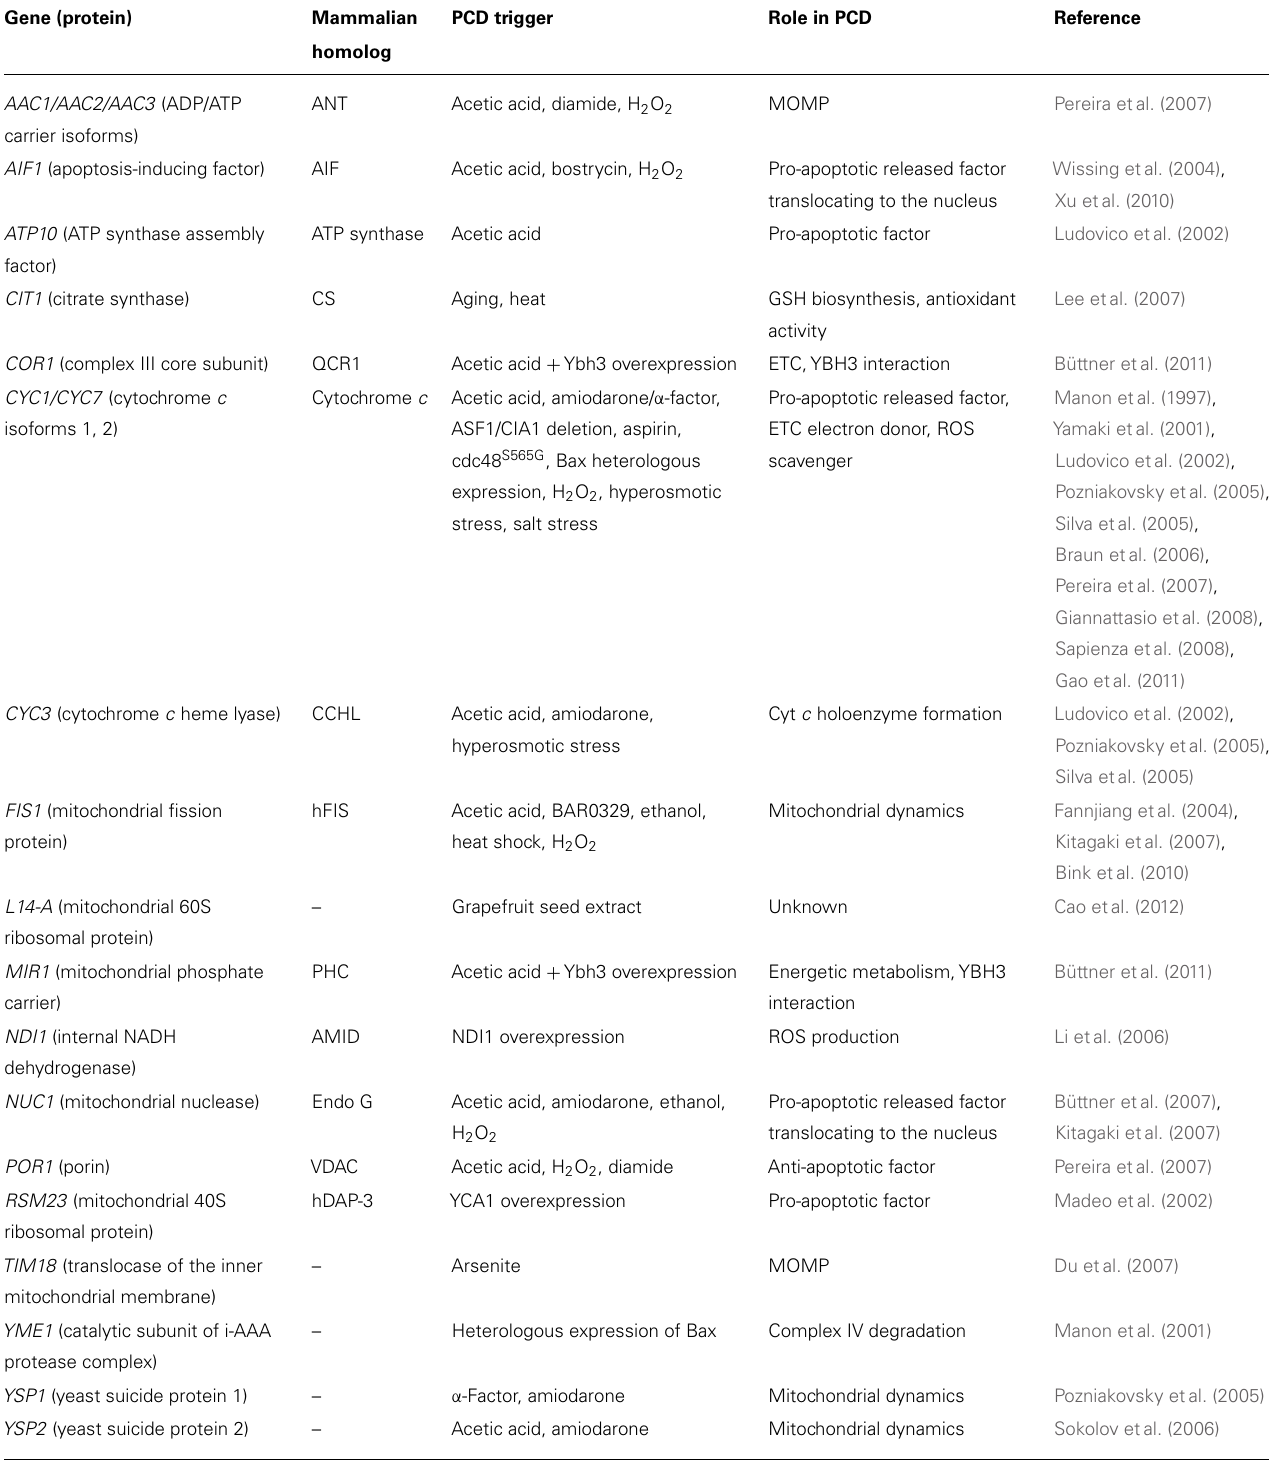
The S. cerevisiae mitochondrial proteins reported in this table have been implicated in PCD induced by different triggers through biochemical and/or genetic studies. ANT, adenine nucleotide translocator; MOMP, mitochondrial outer membrane permeabilization; CS, citrate synthase; GSH, glutathione; QCR1, ubiquinol–cytochrome c reductasecoreprotein;YBH3, yeastBH3-only; ETC,electrontransportchain; CCHL,cytchemelyase; hFIS,humanhomologofFis1p; BAR0329, 4-{[3-(4-chlorobenzyl)- 2-methoxyquinolin-6-yl]methyl}piperazine-1-carboximidamide; PHC,phosphatecarrier;AMID,apoptosis-inducingfactor-homologousmitochondrion-associatedinducer of death; Endo G, endonuclease G;VDAC, voltage-dependent anion channel; hDAP-3, human death associated protein.